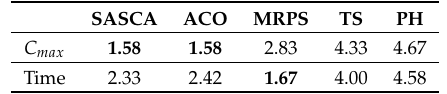
Table 9. Results of Friedman test for the large problems (best results are in boldface).